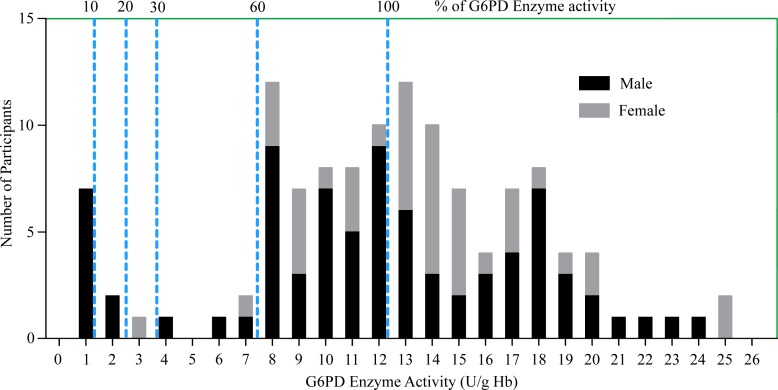
Proportion of G6PD enzyme activity levels for male and female participants compared to adjusted male median value.For each G6PD enzyme activity level (U/g Hb) shown in X-axis, the corresponding value in Y-axis indicates the number of participants. The numbers on top of each dotted line, shown as 10, 20, 30, and 60 on uppermost horizontal line of the graph indicate different cut-off values as percentages for the study population. 60% (shown as 60) of adjusted male median (shown as 100) is the upper limit of cut-off value and the participants with enzyme activities below 60% are considered deficient. Black portion of each bar indicates male participants, whereas gray portion of each bar indicates female participants.